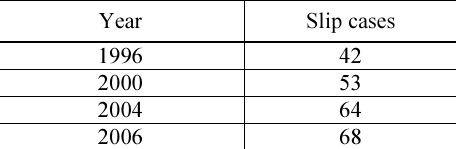
Table 1 . Dynamics of slope slips in